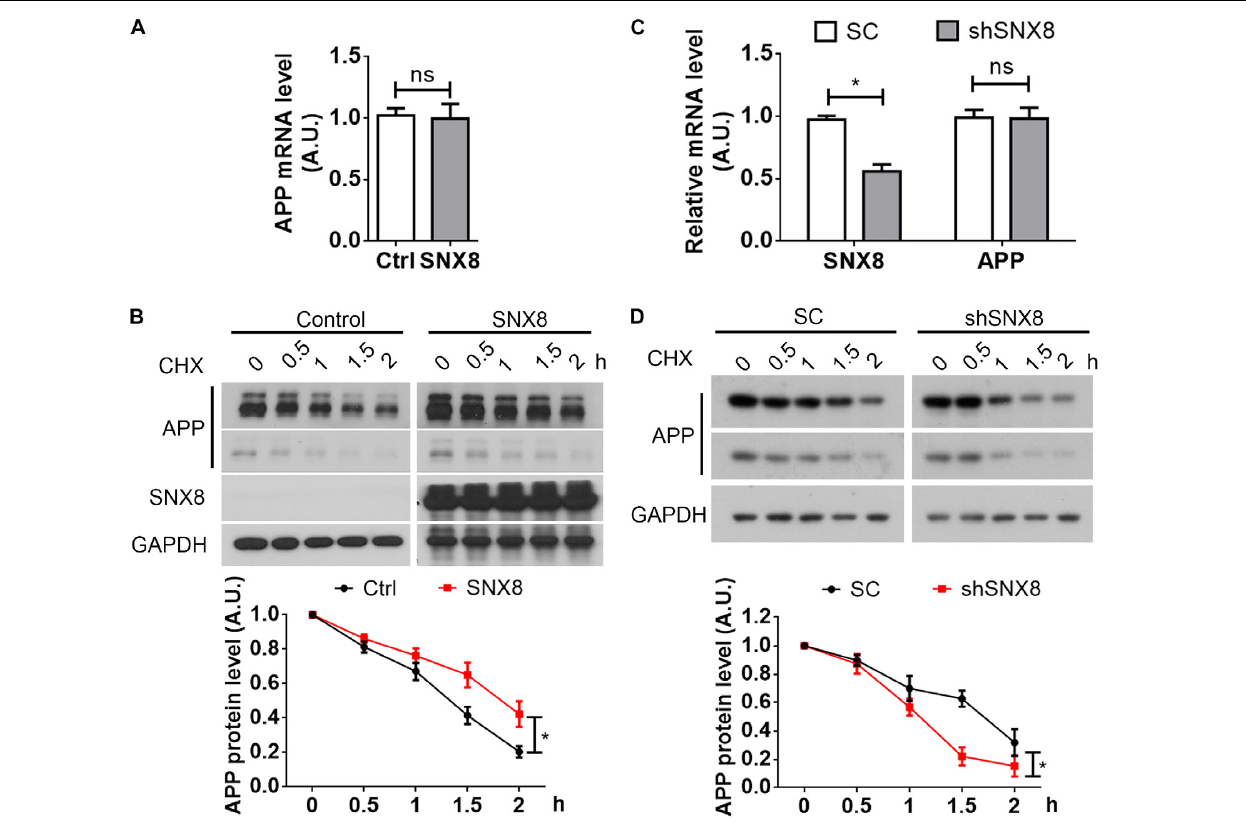
FIGURE 4 | SNX8 Modulates APP Stability. (A) SH-SY5Y cells were transfected with SNX8-myc (SNX8) or control (Ctrl) vectors for 24 h. APP mRNA levels were determined by quantitative real-time PCR, normalized to β -actin levels, and compared to controls (set to 1.0), n = 4. ns: not significant, Mann–Whitney U test. (B) After transfection with SNX8-myc (SNX8) or control vectors for 24 h, SH-SY5Y cells were incubated with 500 µ M cycloheximide (CHX) for the time indicated. Equal protein quantities from lysates were subjected to Western blotting. APP levels were quantified by densitometry, normalized to those at time point zero (set to 1.0), and compared to respective controls, n = 4, ∗ p < 0.05, two-way ANOVA. (C) HEK293T cells were transfected with APP-myc for 24 h, then transfected with scrambled control (SC) or SNX8 shRNA (shSNX8) vectors for 48 h. SNX8 and APP mRNA levels were determined by quantitative real-time PCR, normalized to β -actin levels, and compared to respective controls (set to 1.0), n = 4, ∗ p < 0.05, ns: not significant, Mann–Whitney U test. (D) After transfection with APP-myc for 24 h and scrambled control (SC) or SNX8 shRNA (shSNX8) vectors for 48 h, HEK293T cells were incubated with 500 µ M CHX for the time indicated. Equal protein quantities from lysates were subjected to Western blotting. APP levels were quantified by densitometry, normalized to those at zero time point (set to 1.0), and compared to respective controls, n = 4, ∗ p < 0.05, two-way